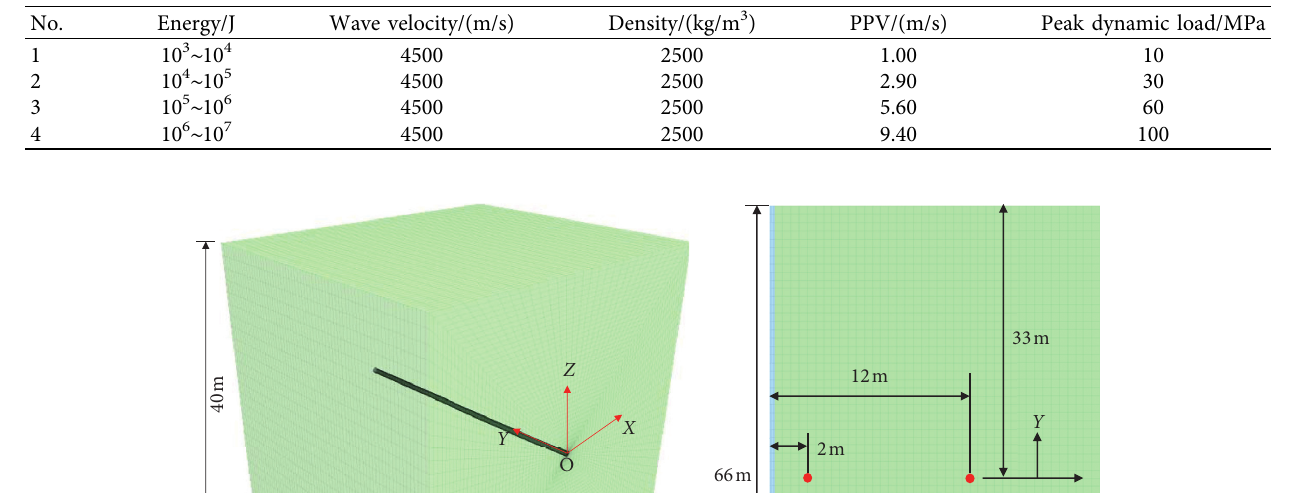
Table 2: Relationship between mine tremor energy and peak dynamic load.